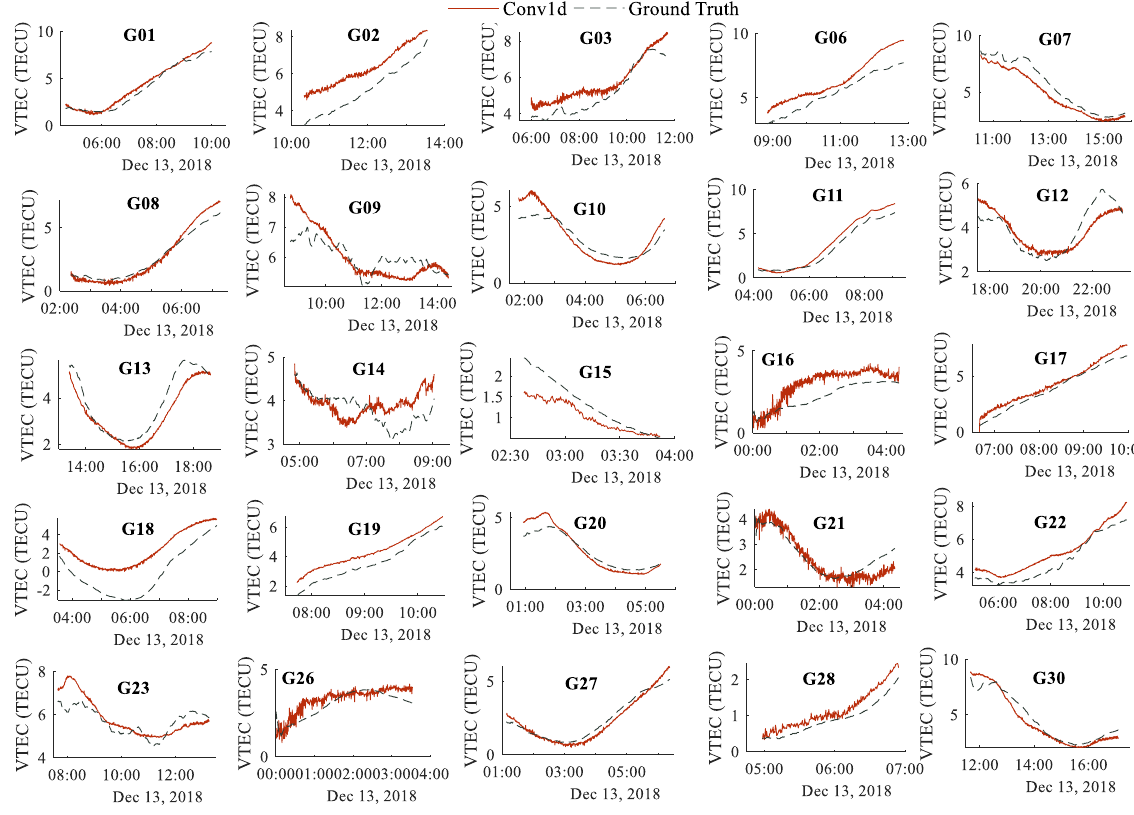
Figure 2. Conv1d versus ground truth per satellite PRN for bor1 station.